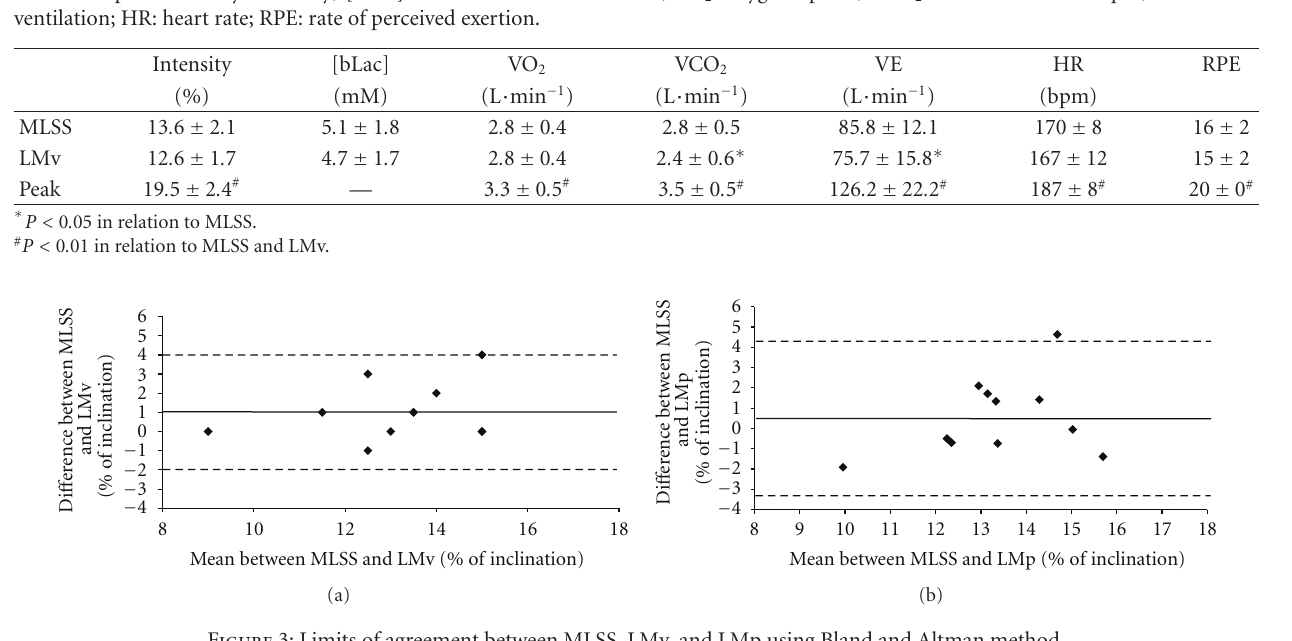
Figure 3: Limits of agreement between MLSS, LMv, and LMp using Bland and Altman